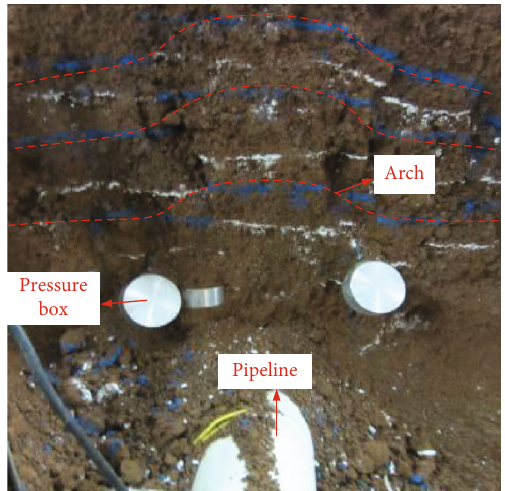
Figure 6: Deformation of soil on the upper side of